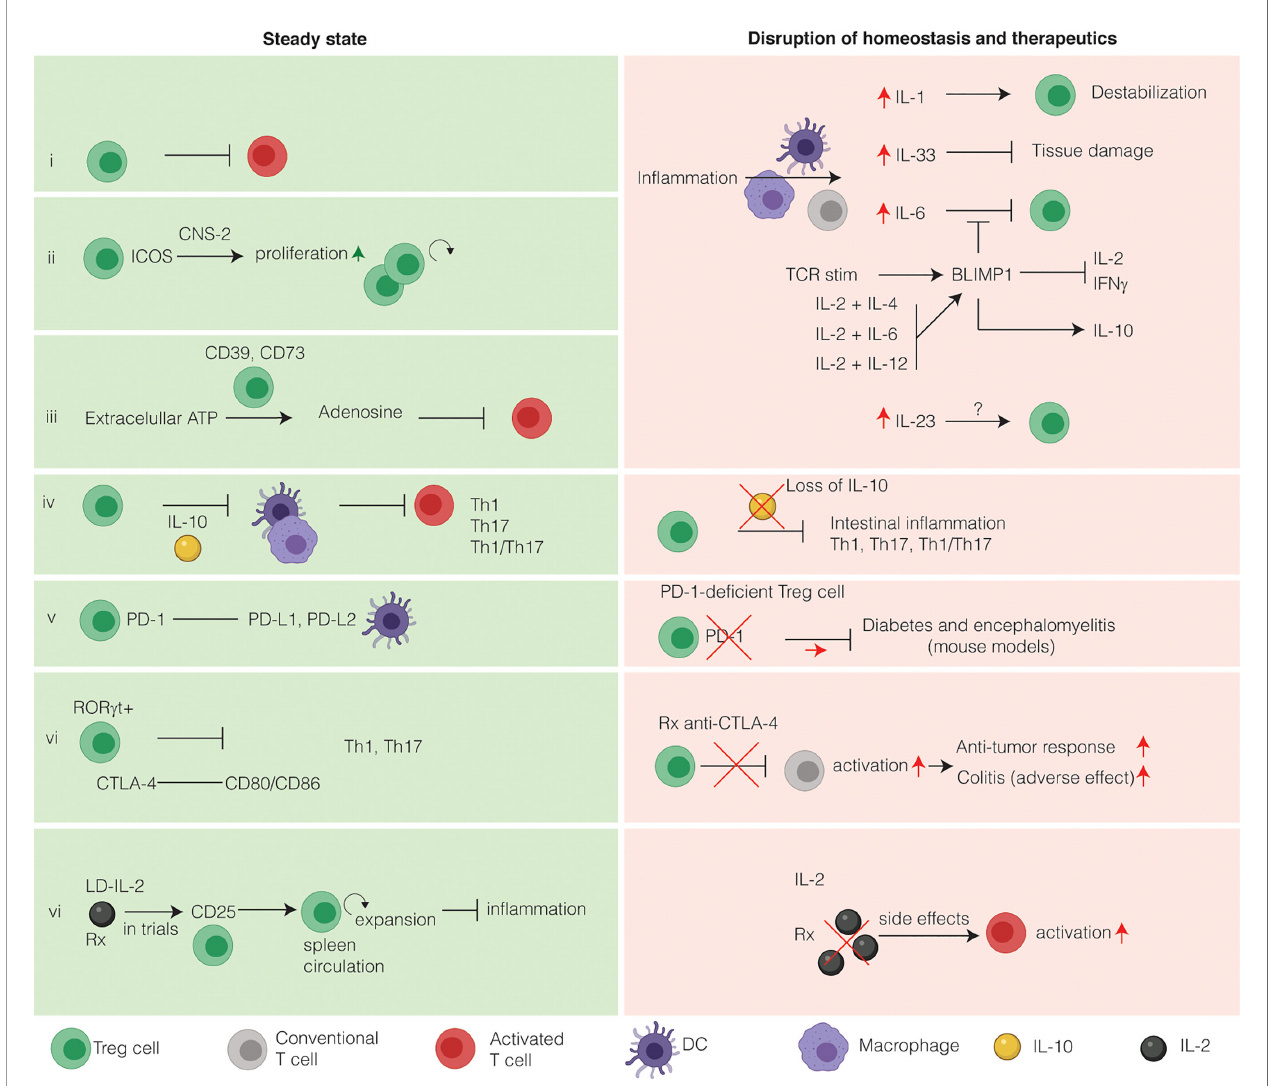
FIGURE 2 | Intestinal Treg cells tightly maintain intestinal immunehomeostasisandrelevancefor immunotherapy . IntestinalTreg cellshave severalmarkers that discriminate them from other Treg cells. Under homeostatic conditions, Treg cells suppress effector T cells to prevent in fl ammation(i). During in fl ammation, several in fl ammatory cytokines alter the phenotype ofintestinal Treg cells. (ii) Inducible co-stimulator (ICOS) stabilizes intestinal Treg cells in a CNS2-dependent manner. (iii) Extracellular ATP is converted to the immunosuppressive adenosine byTreg cellsexpressing CD39 and CD73. CD73 is induced byTGF b . (iv) The main immunosuppressive cytokine secreted by intestinal Treg cells is IL-10. IL-10 functions to inhibit T-helper 1 (Th1), Th17 and Th1/Th17 in fl ammationin a STAT3-dependent manner via IL-10R signaling on APCs, limiting in fl ammasome activation. Onthe other hand, loss of IL-10 both in mice and in humans leads to intestinal in fl ammationand IBD, respectively. The mainco-stimulatory receptors expressed onTreg cells are programmed death receptor (PD-1) (v) and cytotoxic T-lymphocyte associatedprotein 4 (CTLA-4) (vi). Boththese co-stimulatory receptors are exploited therapeutically to increase the anti-cancer immune response. Anti-CTLA-4 therapy has colitis as a frequent side-effect, whereas colitisis not associated with blockade of the PD-1 pathway. (vi)Because Treg cellsexpress the highaf fi nityreceptor CD25, theyrespondto low doses of IL-2 byexpansion, thus limiting in fl ammation. LD-IL-2 is investigated ina clinical trial for its use in patients with IBD. Incontract to LD-IL-2, a high dose of IL-2 will activate T cells and leadto deleterious side effects and therefore isnot used in clinical